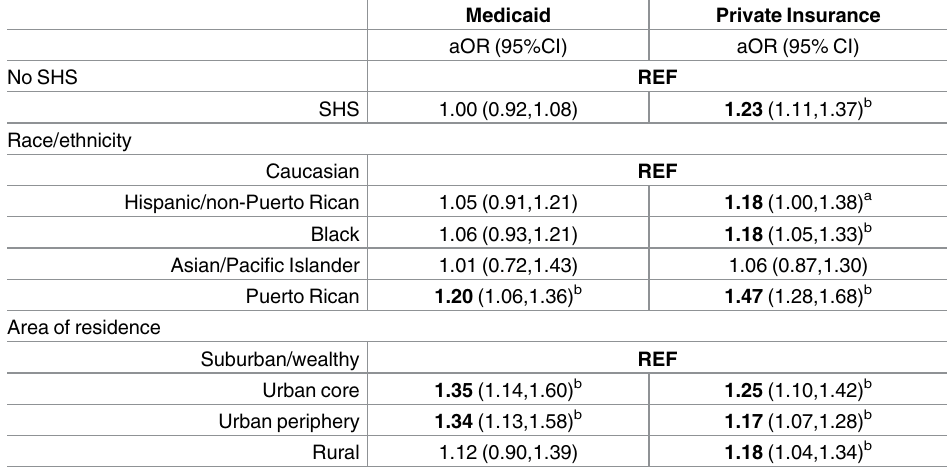
Table 5. Adjusted Odds Ratios (aOR) for Persistent Asthma, Stratified by Insurance Status.